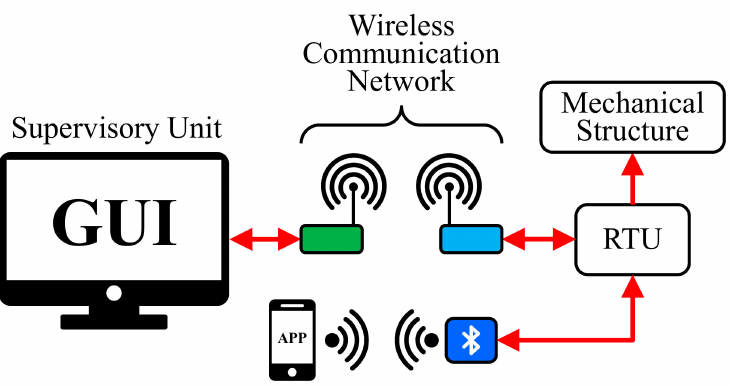
Figure 1. Block diagram of the heliostat control